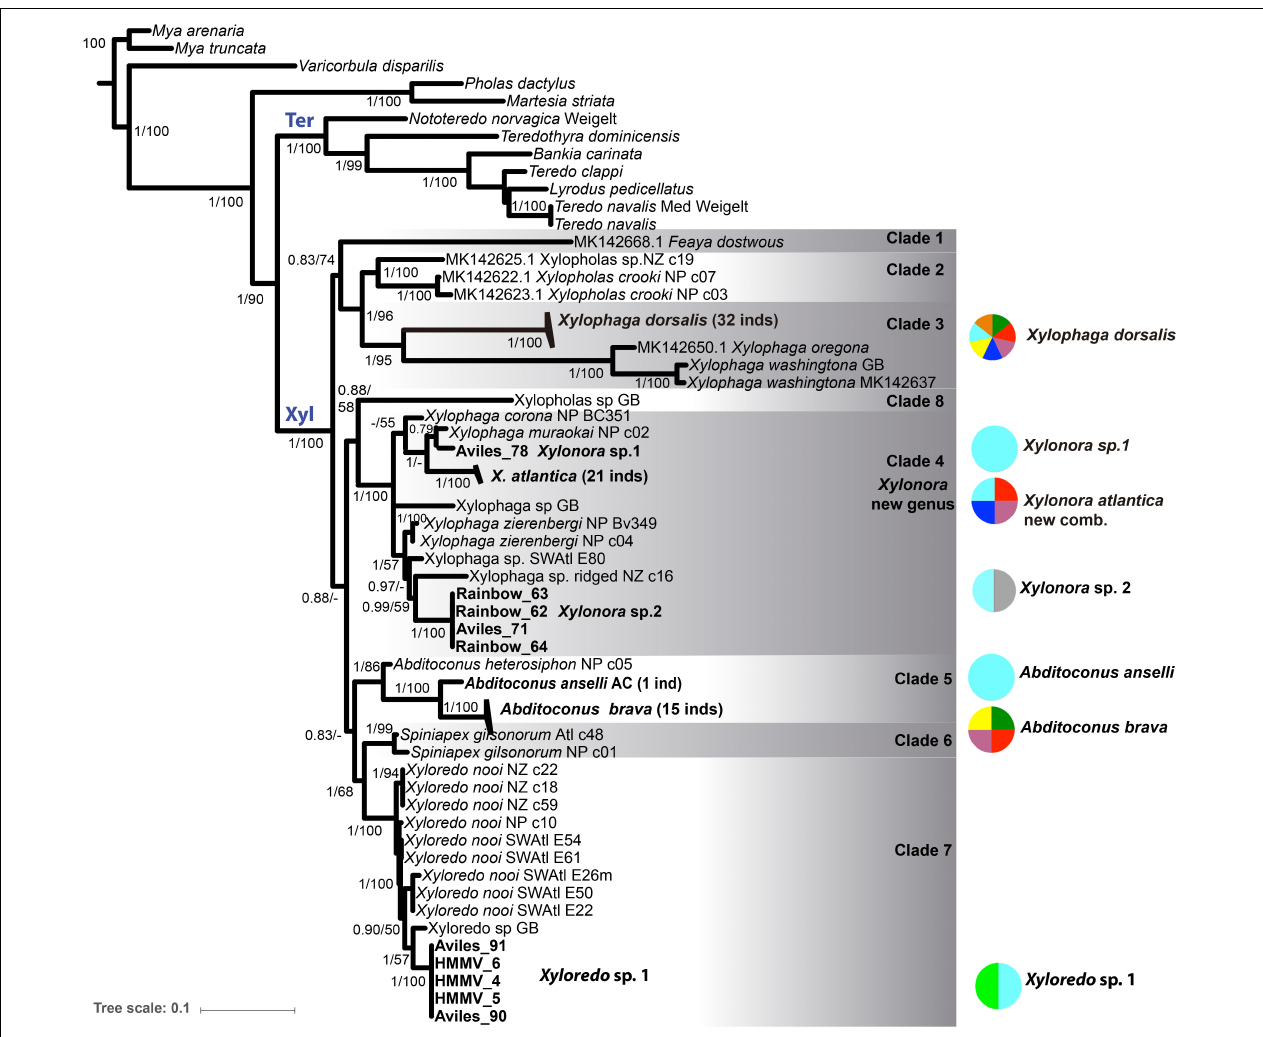
FIGURE 3 | Bayesian inference (BI) and Maximum likelihood (ML) phylogenetic analysis based on the concatenated data set of COI, 18S and 28S rRNA genes (MAFFT aligned). Statistic support is indicated on the nodes (BI/ML, values < 0.5 pp or 50% bs not shown). Bold taxa names: sequences from this study, including locations. Not-bold taxa names: GenBank sequences; inds = number of sequenced individuals. (see Supplementary Table S3 for accession numbers). Xyl: node of Xylophagaidae; Ter: node of Teredinidae. Colored circles and associated numbers represent the geographic and depth distributions of the species in this study; circle colors as in Figure 1